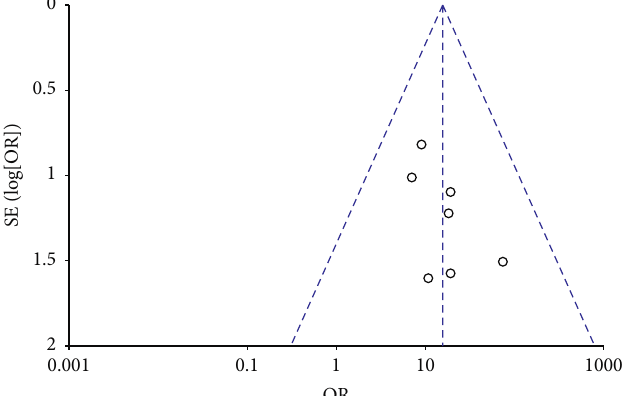
Figure 8: A funnel plot of MH closure rate at 6 months after surgery showing no significant publication bias. MH � macular hole, SE � standard error, OR � odds